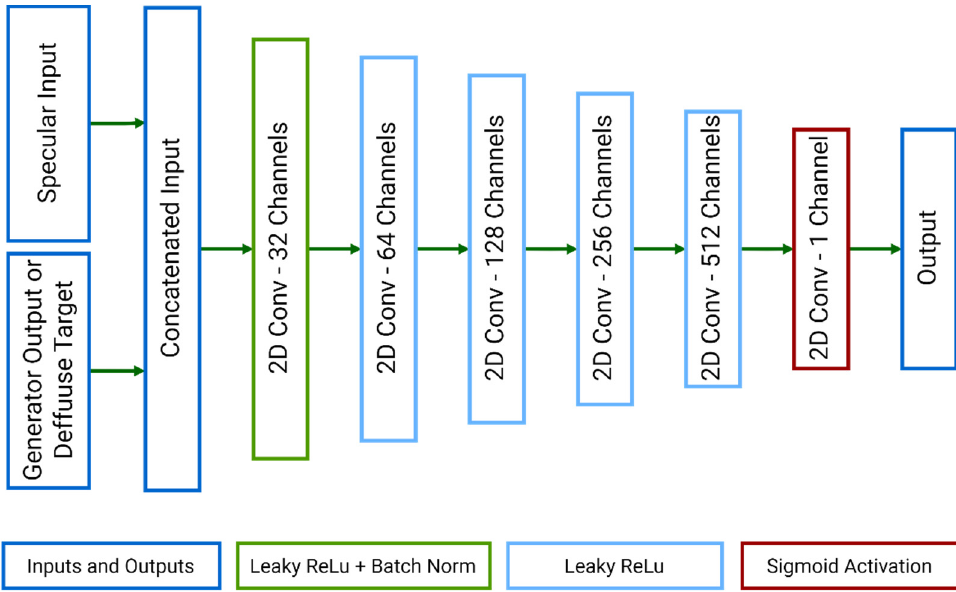
Figure 13. The discriminator network architecture used in SpecToPoseNet .